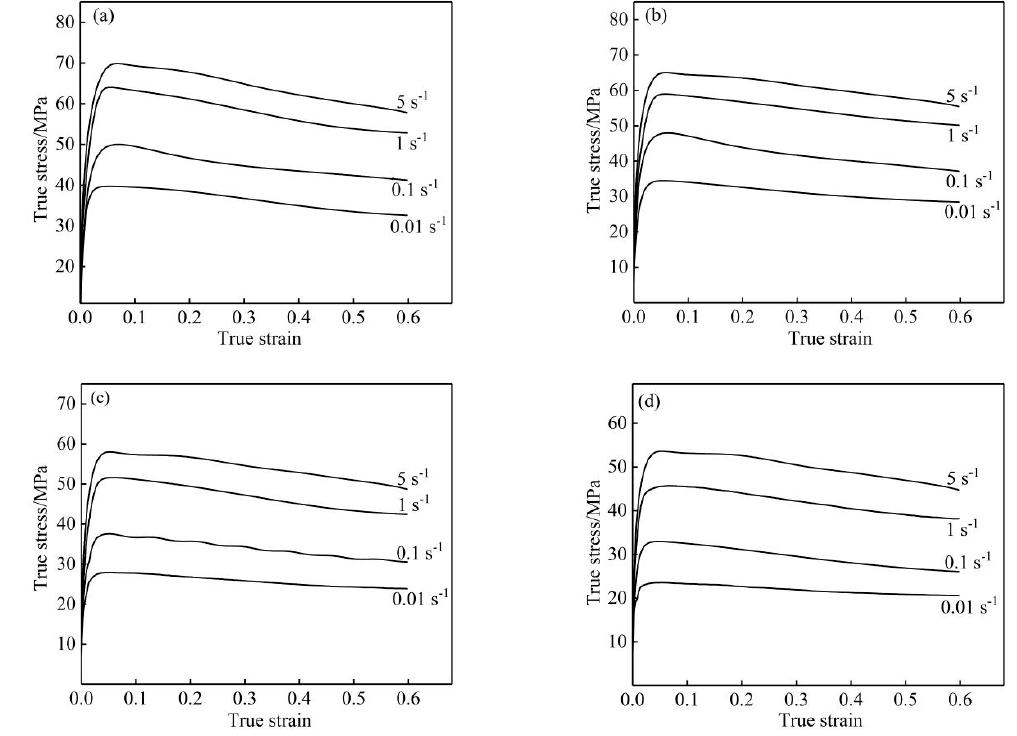
Figure 3. Stress–strain diagrams of nano-SiCp/Al-Si composites: ( a ) 470 °C; ( b ) 490 °C; ( c ) 510 °C; ( d ) 530 °C.